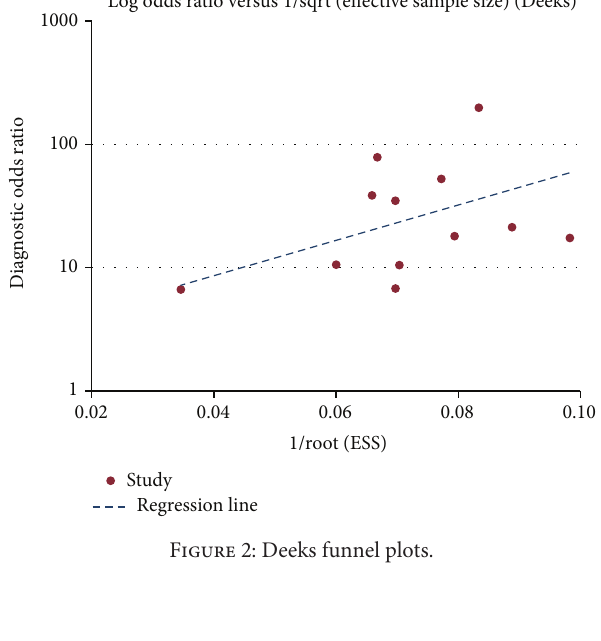
Table 3: Metaregression analysis of diagnostic